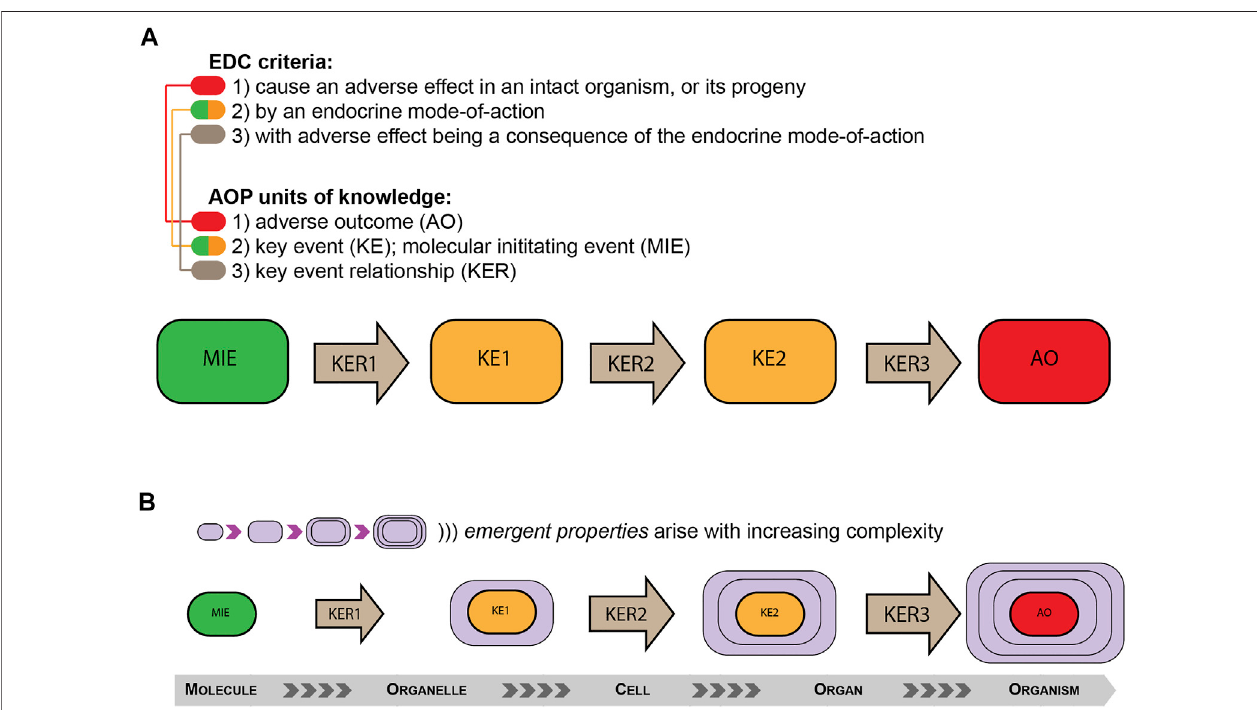
FIGURE1| Identifying Endocrine DisruptingChemicals(EDCs) using theAdverseOutcomePathway(AOP) concept. (A) Current criteria fortheidenti fi cation of,for instance, pesticides and biocideswithendocrinedisrupting properties(ECHA/EFSA, 2018) aligns withthe basic building blocks comprising anAOP;from the molecular initiating event (MIE) or key events (KEs) through to adverse outcomes (AOs), which are linked by key event relationships (KERs) that infer causality. (B) Emergent properties refer to entirely new and unexpected properties that arise as complexity of a system increases. Although KERs in principle can incorporate knowledge that allows for predicting also emergent properties, they remain exceedingly dif fi cult to predict at the higher levels of complexity, as they do not belong to any one part of the system.